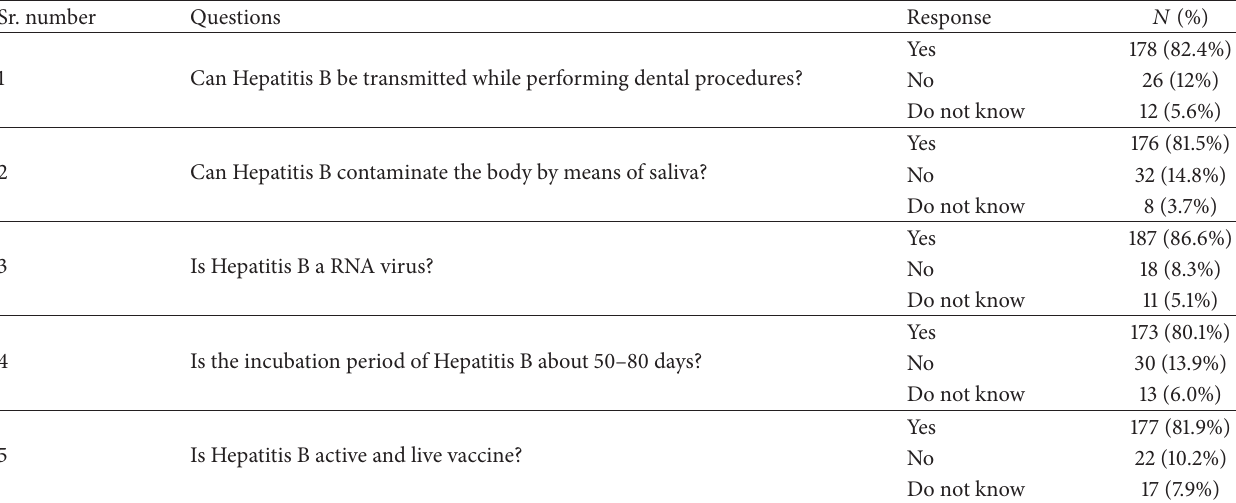
Table 1: Knowledge of the students regarding Hepatitis B.